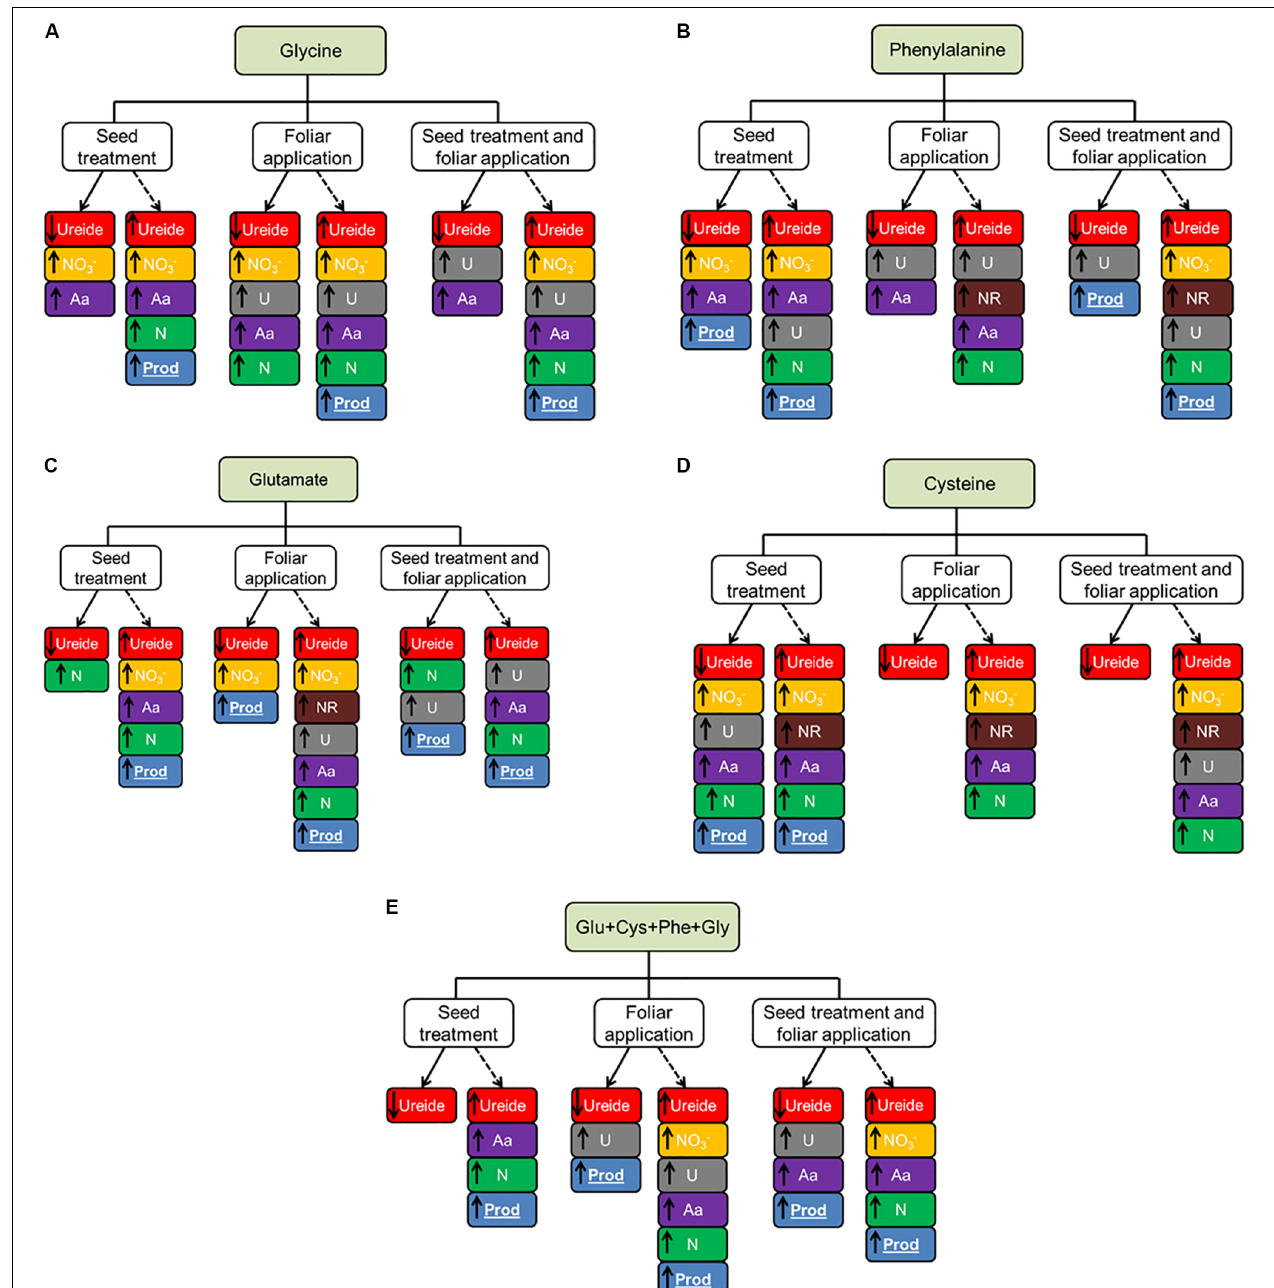
FIGURE 6 | Summary of the effect of glycine (Gly, A ), phenylalanine (Phe, B ), glutamate (Glu, C ), cysteine (Cys, D ) and set of amino acids (Glu+Cys+Phe+Gly) (E) , applied in the seed treatment, foliar aplication and both, in soybean crop in greenhouse experiment (continuous line) and field experiment (dotted